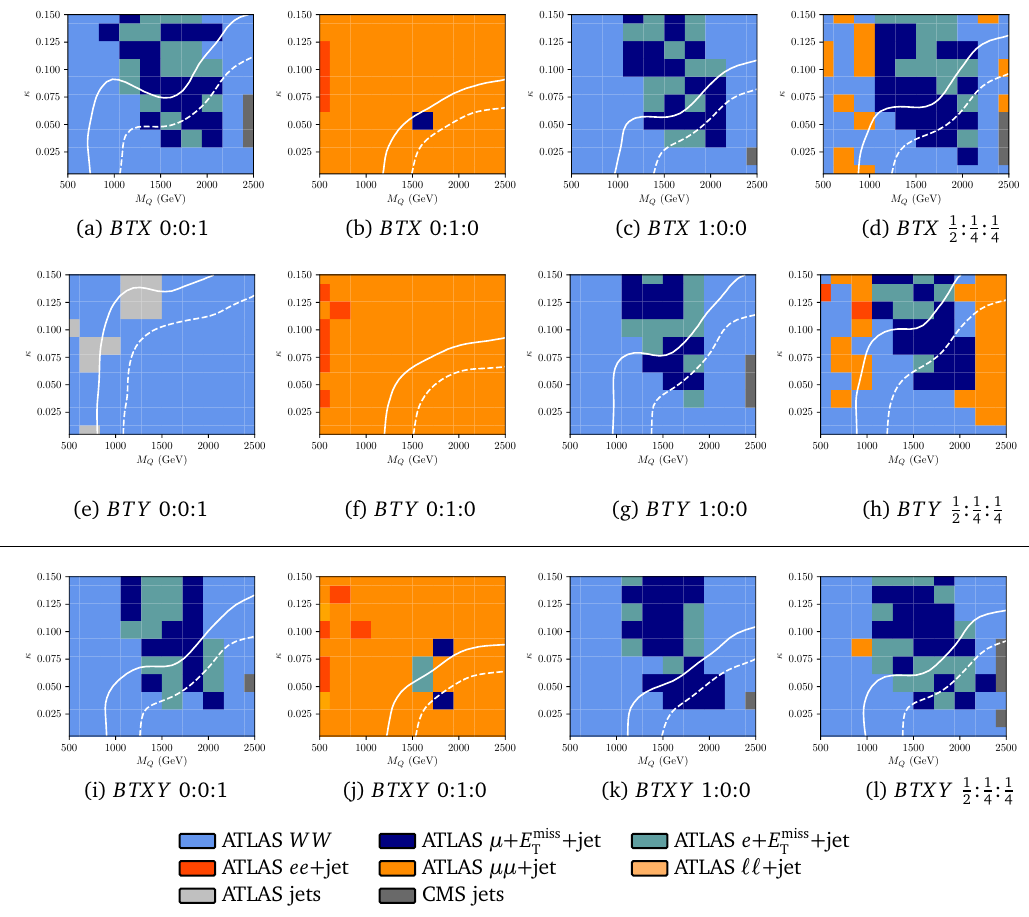
Figure 11: Sensitivity of LHC measurements to VLQ triplet production in the κ vs VLQ mass plane, where κ is the coupling to first-generation SM quarks. All VLQ masses are set to be degenerate. The multiplets are given as rows: (a)–(d)( B , T , X ) triplet, (e)–(h)( B , T , Y ) triplet, and for comparison to the main text, the (i)–(l)( B , T , X , Y ) quadruplet. The VLQ branching fractions to W : Z : H are arranged in columns of